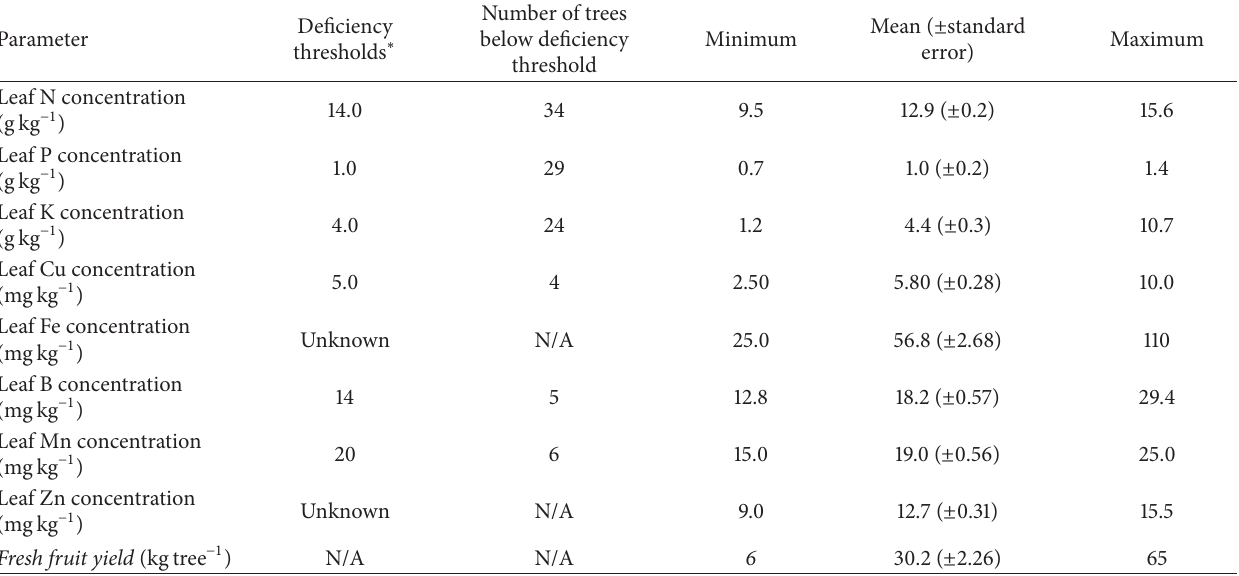
Table 3: Leaf mineral composition of main macro- and micronutrients and olive fruit yield.